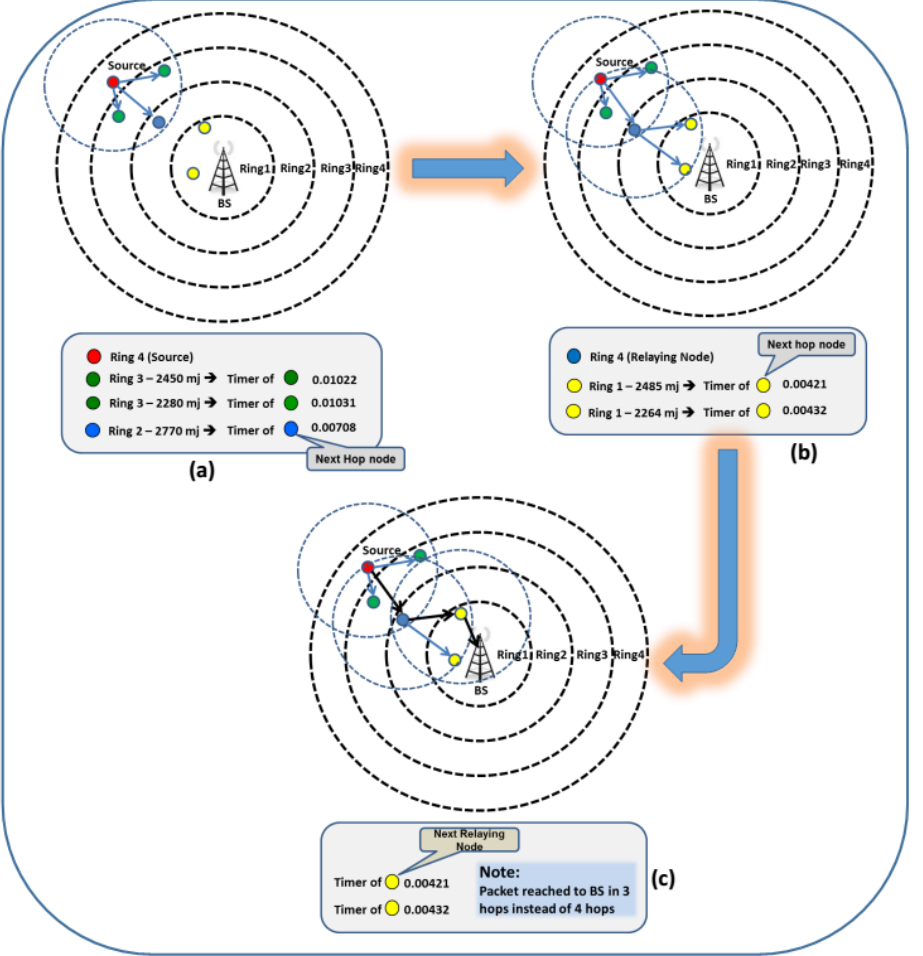
Figure 6. Routing illustration of RARZ.